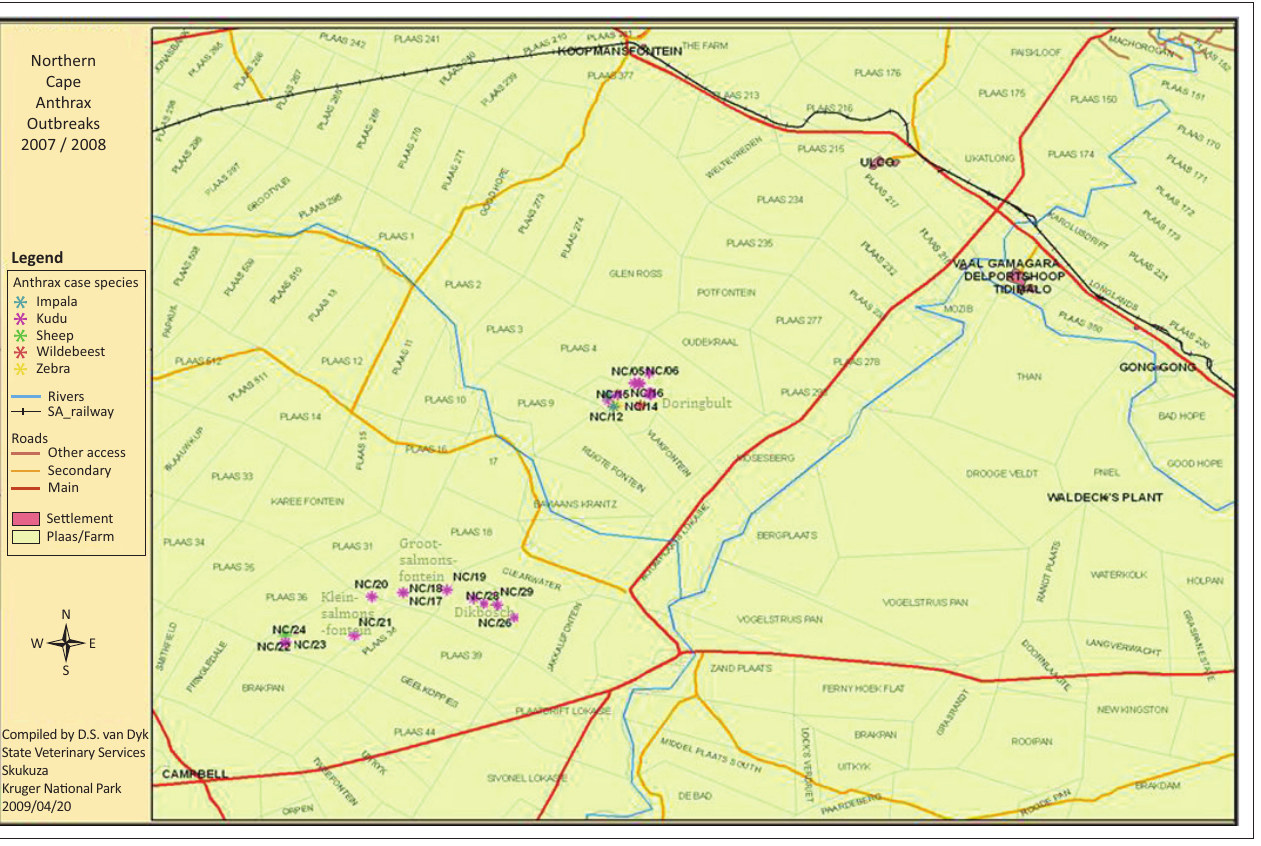
FIGURE 2: Anthrax-positive carcass sites indicating the distribution of susceptible species discovered on farms during the 2007–2008 anthrax outbreaks in the Ghaap Plateau in the Northern Cape province, South